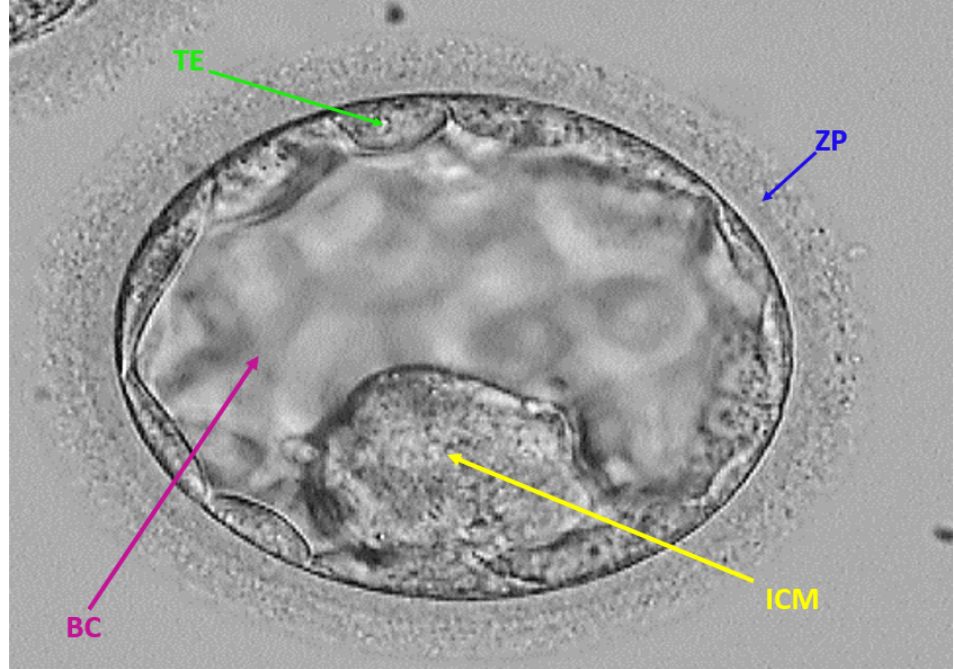
Figure 1. Embryonic components at the blastocyst stage. Inner cell mass (ICM), blastocoel (BC), trophectoderm (TE), and zona pellucida